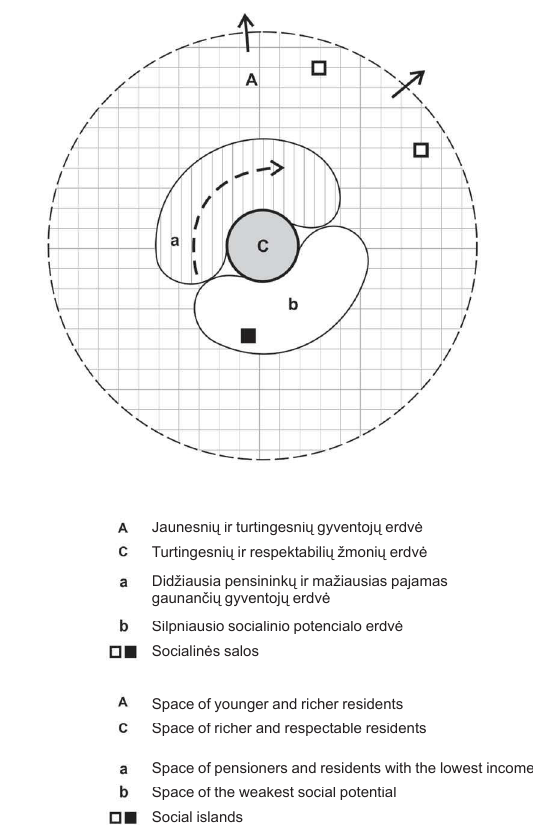
Fig 5 . Social spaces and deviations of Vilnius city (2005)